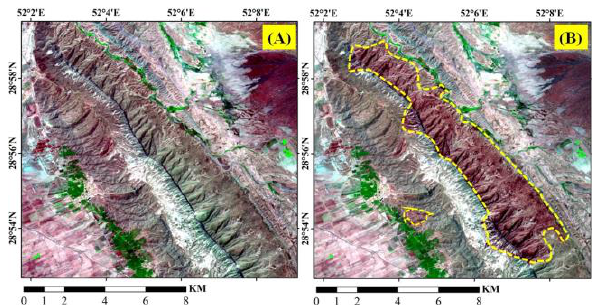
Figure 3. Sentinel-2 images, pre-fire (A), and post-fire (B).